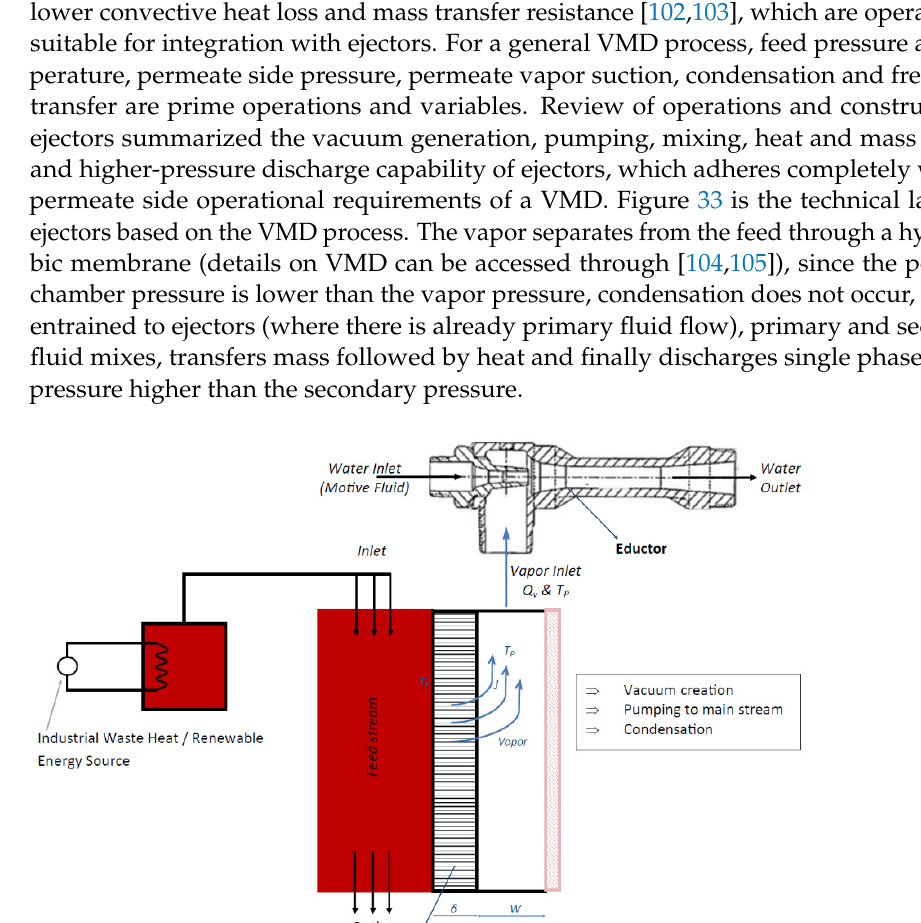
Figure 34. Numerical model algorithm of ejector based VMD.